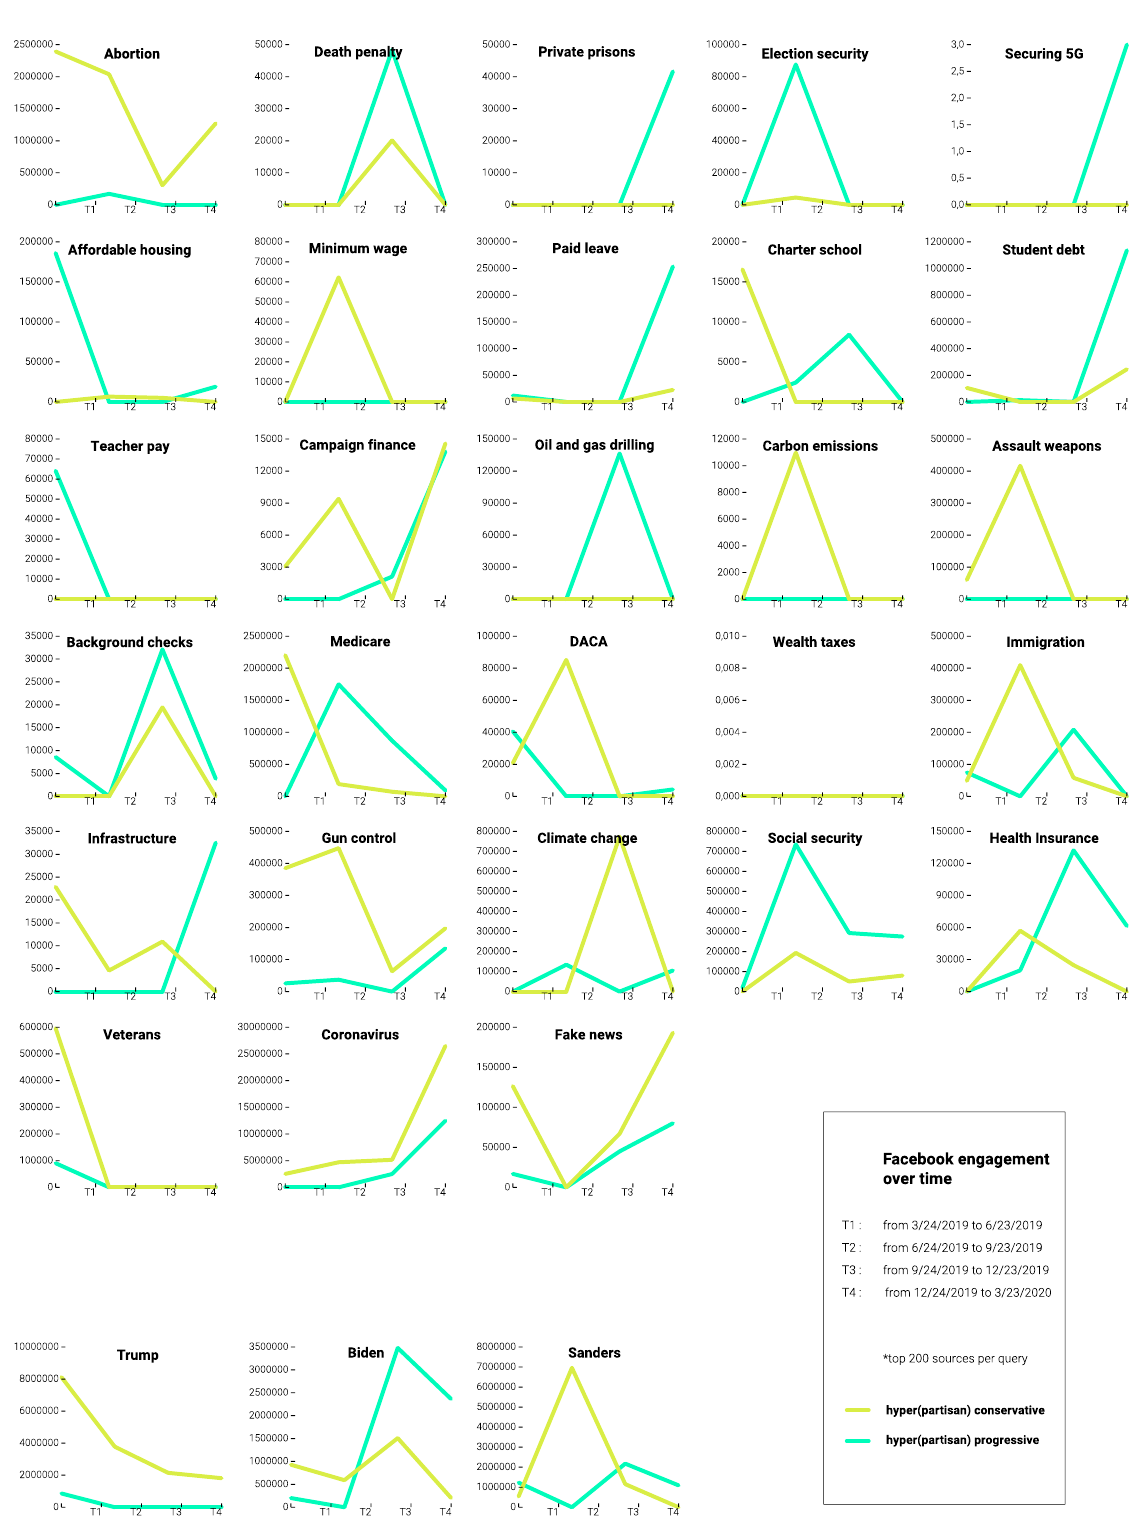
Figure 9. Facebook engagement scores of hyperpartisan conservative and hyperpartisan progressive sources for political candidate and social issue queries, March 2019 - March 2020. Absolute numbers shown for the sake of trend comparison. Source: